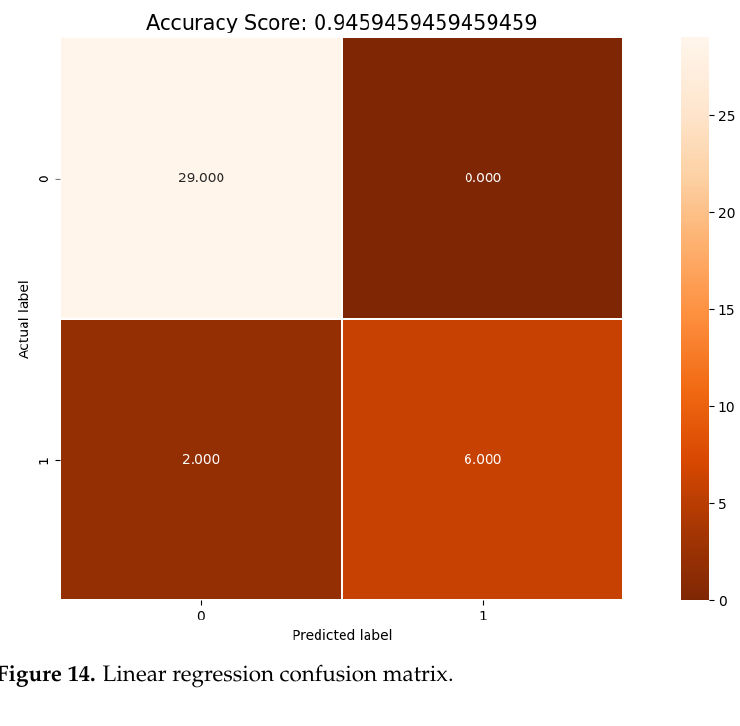
Figure 14. Linear regression confusion matrix.